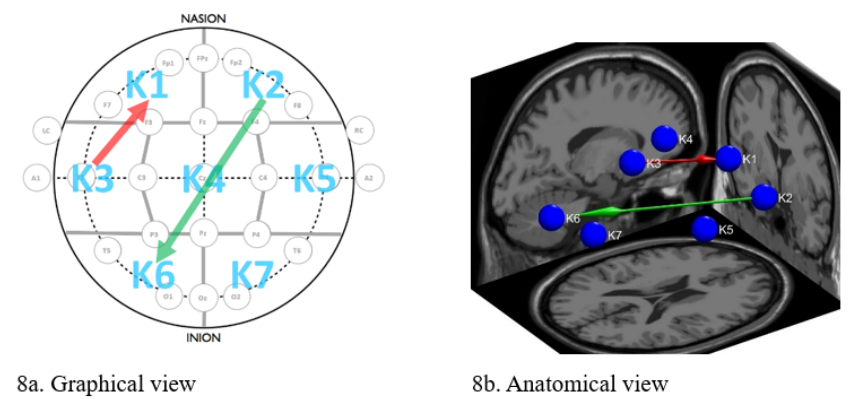
Figure 8. Estimated brain connectivity in the problem-identifying phase for spatial intelligence tasks.